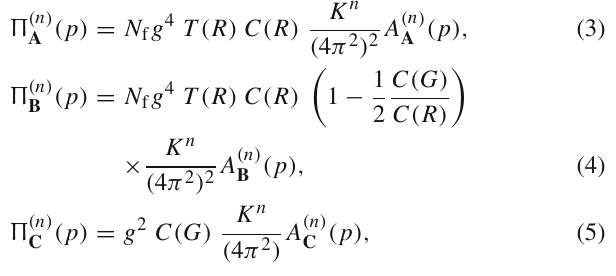
Two-loop corrections to the diagram in Eq. (1) correspond to attaching a gauge propagator to the fermion loop: as no additional N f multiplicity is added, this diagram will effec- tively contribute to order K 2 / N f , thus providing next-to- leading order terms. Now, replacing the simple gauge prop- agator with a bubble-chain , will not increase the 1 / N f